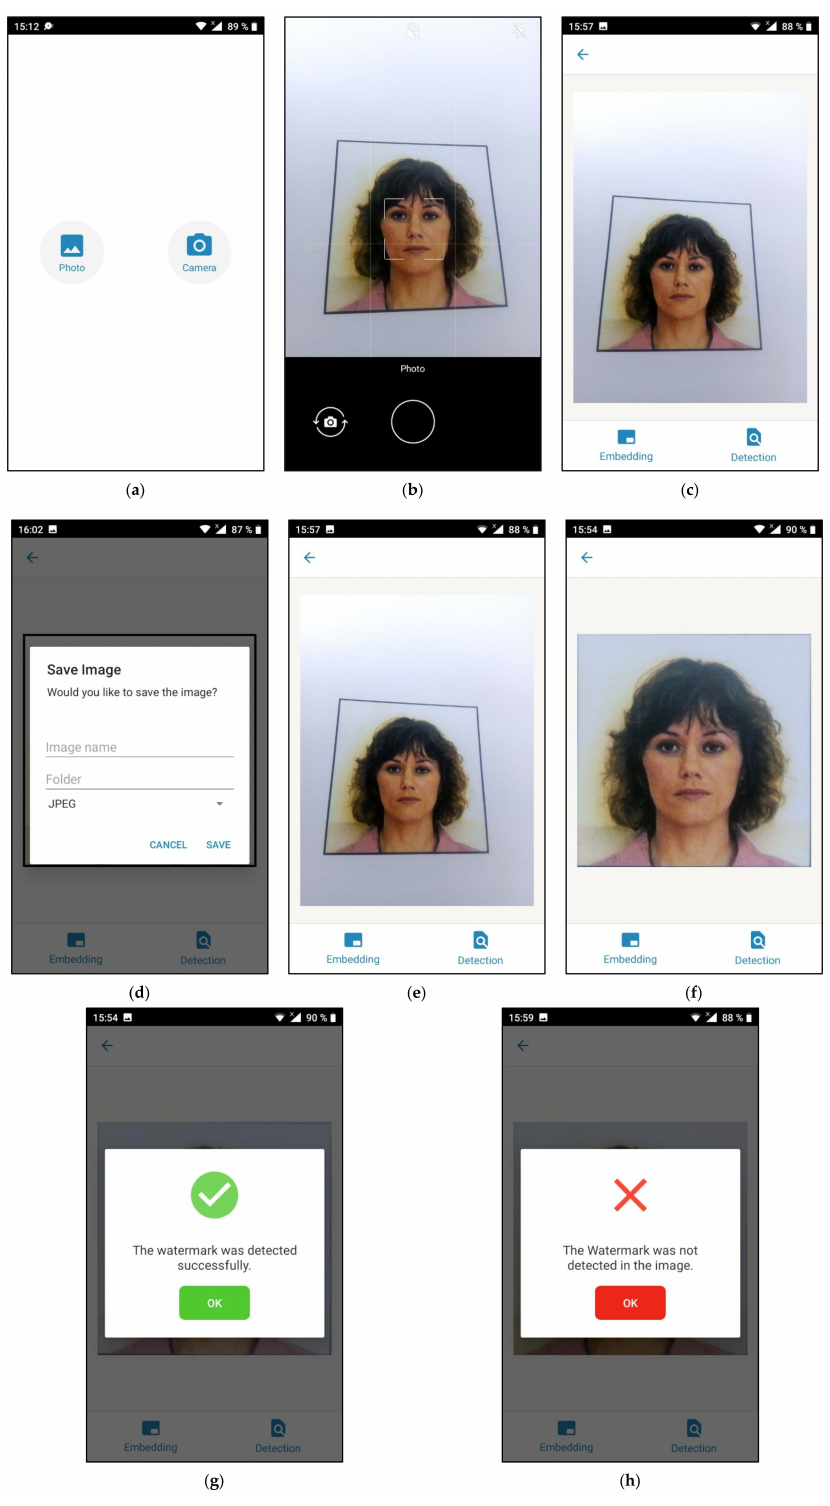
Figure 9. Watermark detection process: ( a ) the main activity where the user can press the camera key to access the camera of the device; ( b ) user takes picture freehandedly; ( c ) the captured image is displayed in the main screen of the application; ( d ) activity to name and save the captured image; ( e ) the captured image is displayed and the user can press detection; ( f ) geometrically corrected image is displayed; ( g ) detection decision of the existence of the watermark in the captured image; ( h ) detection decision of the absence of the watermark in the